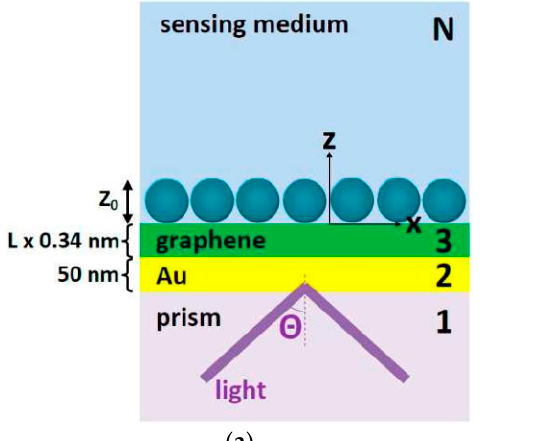
Figure 3. The SPR structure investigated by: ( a ) Wu et al. (left) and ( b ) Choi et al. (right) (adapted with permission from Reference [31,32] © The Optical Society).